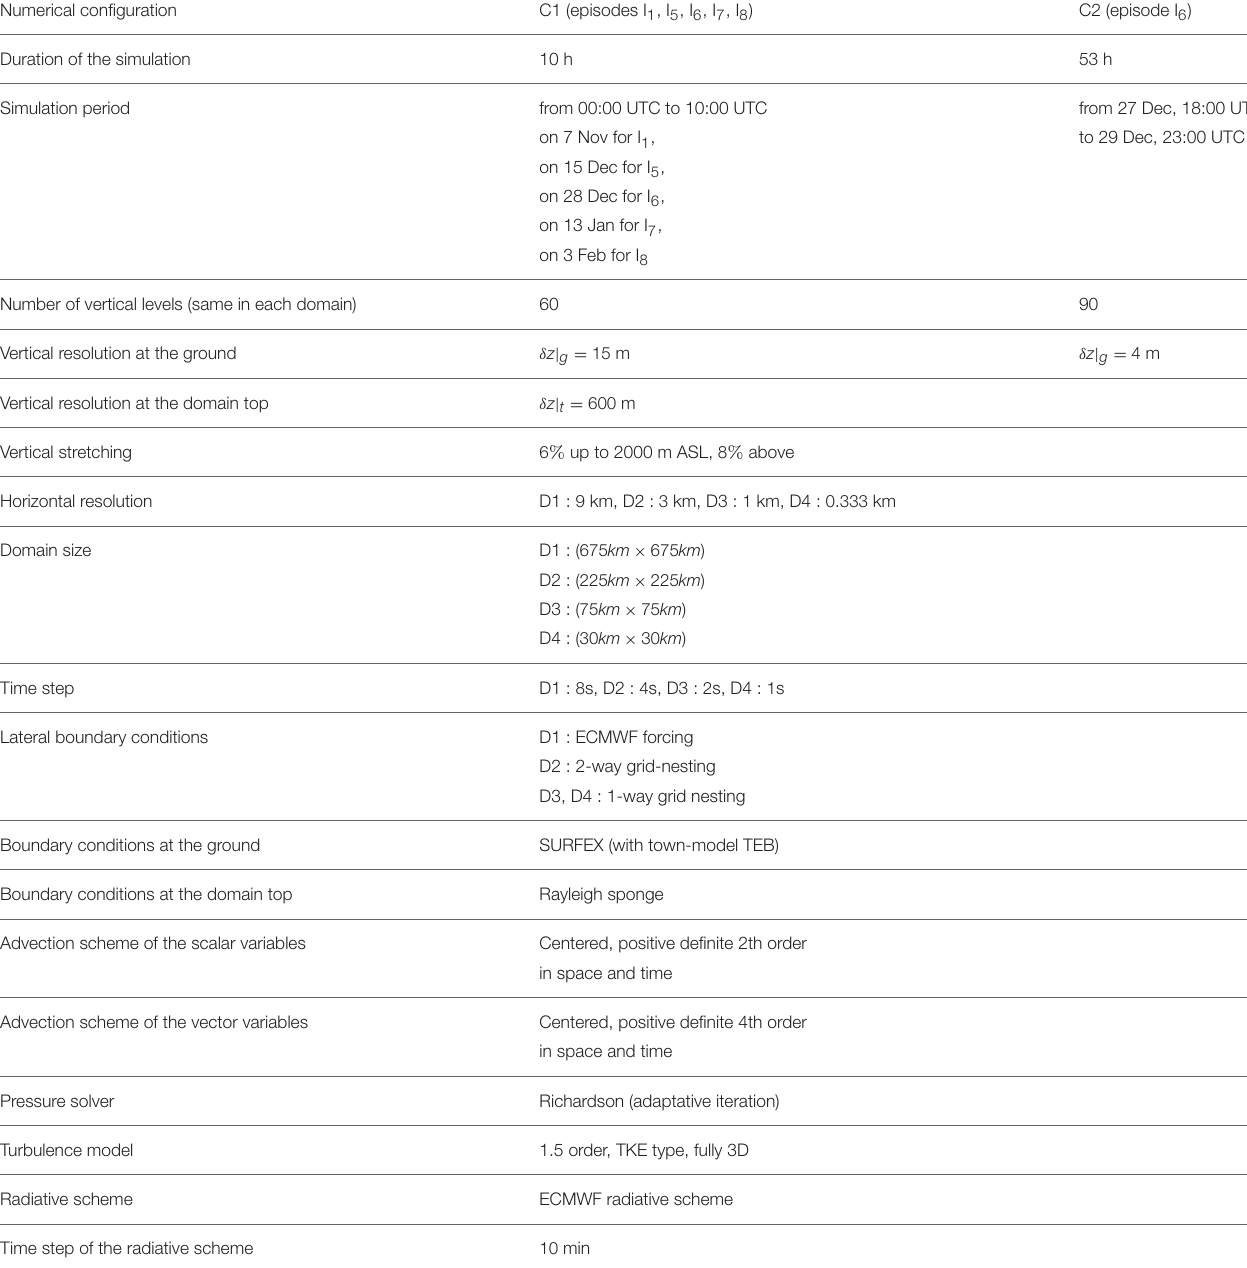
TABLE 3 | Main parameters of the numerical